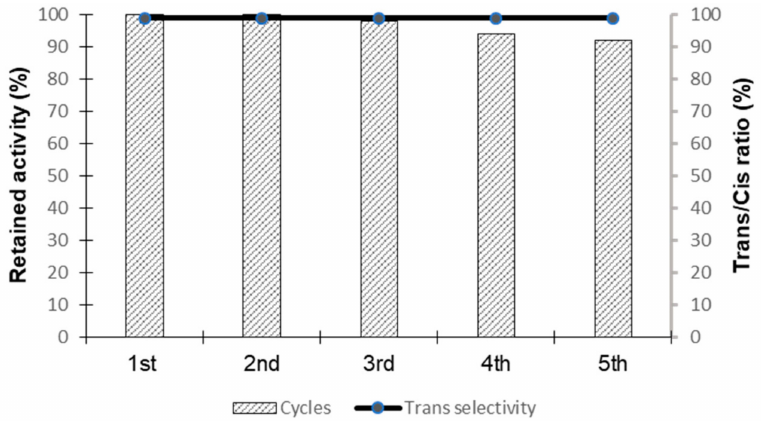
Figure 6. Recyclability of GTL σ -A193Cp-PdNPs bionanohybrid in the Heck reaction. Conditions: 1 (0.274 mmol), 2 (0.55 mmol), 1 mL DMF/H 2 O (75/25), 1.5 equiv NEt 3 , 1 mg of nanocatalyst, 65 ◦ C.